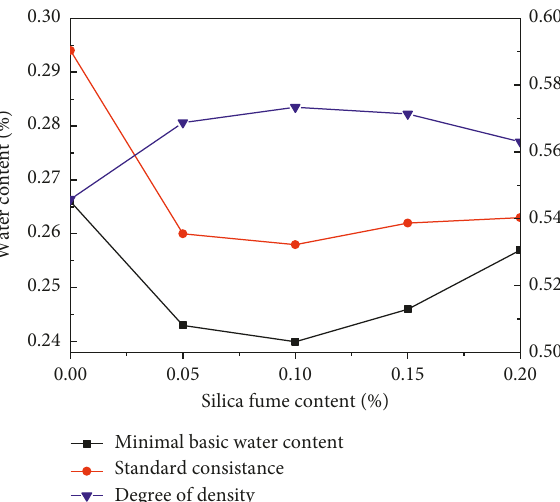
Figure 2: Fly ash content effect on standard consistence, minimal water requirement, and stacking density.